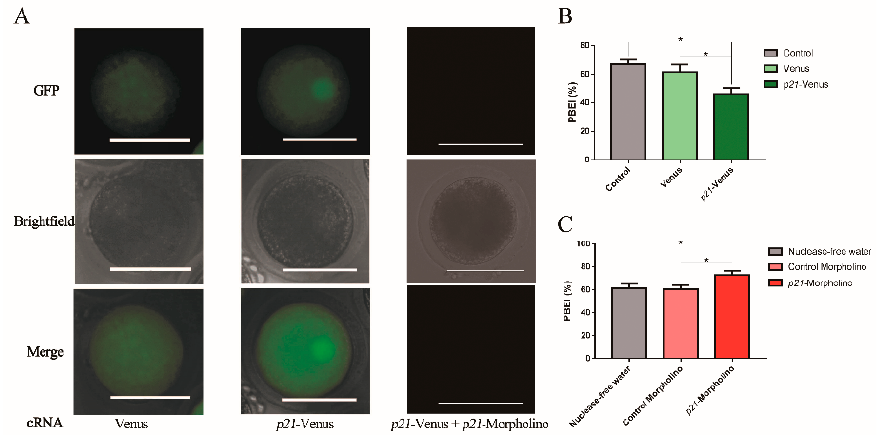
Figure 2. E ff ects of p21 on oocytes: ( A ) cRNA microinjection of Venus or p21 -Venus and co-injection with p21 -Venus cRNA and p21 -Morpholino in oocytes under Fluorescence microscope; scale bar = 100 µ M; ( B ) the e ff ects of p21 overexpression on the PBEI(%); and ( C ) the e ff ects of p21 interference on the PBEI(%). * indicates p <